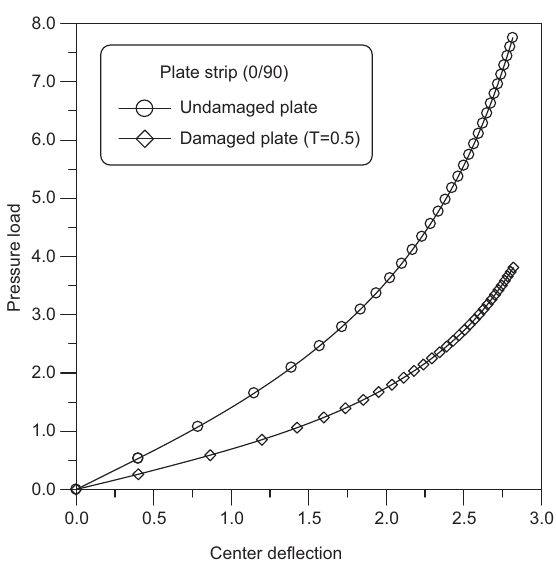
Figure 10 Load-defl ection curve of laminated composite plate under pressure load.